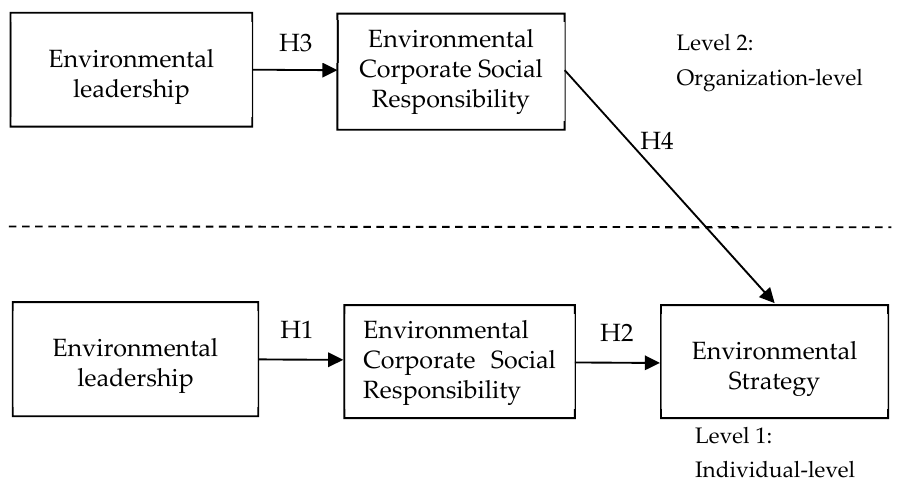
Figure 1. The HLM of this research. Note: H1 = Hypothesis 1; H2 = Hypothesis 2; H3 = Hypothesis 3; H4 = Hypothesis 4.